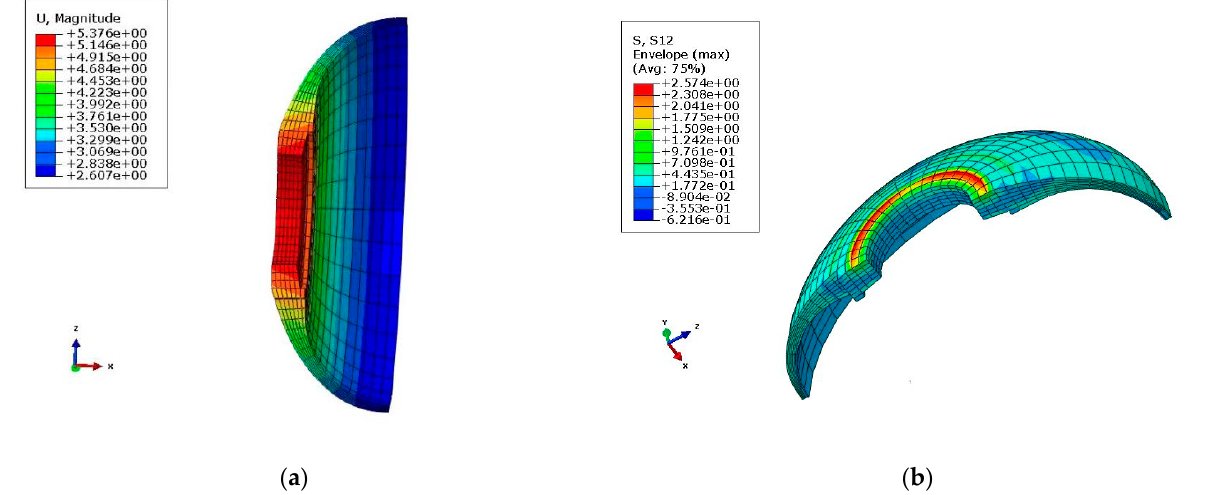
Figure 5. Deformation and maximum shear stress diagrams of the front connector: ( a ) deformation diagram; ( b ) maximum shear stress in XY -direction ( τ xy = 257 × 10 − 2 MPa). Table 4. Finite element calculation results.